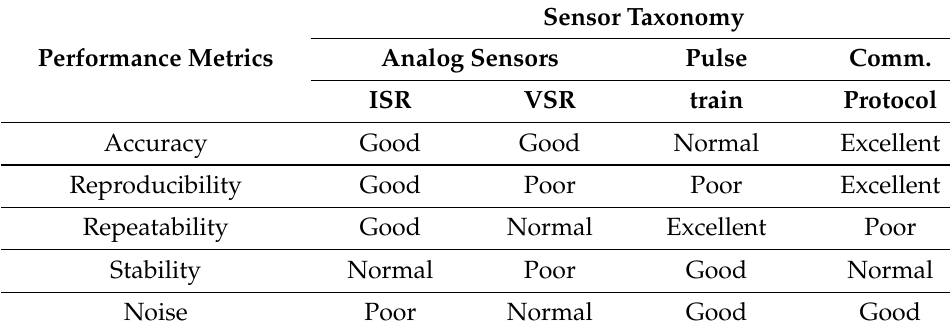
Table 7. Sensor performance